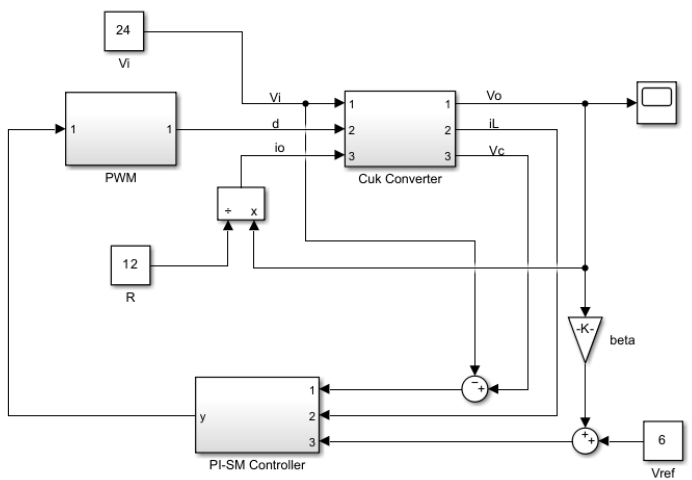
Figure 2. Block diagram of simplified double-integral sliding-mode current control of the DC-DC Cuk converter.